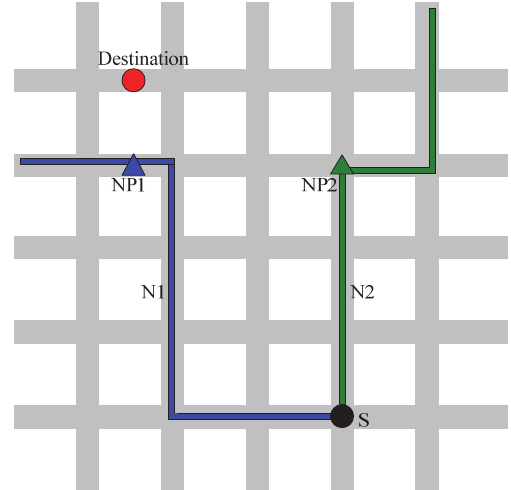
Figure 2. Example of calculation of the Nearest